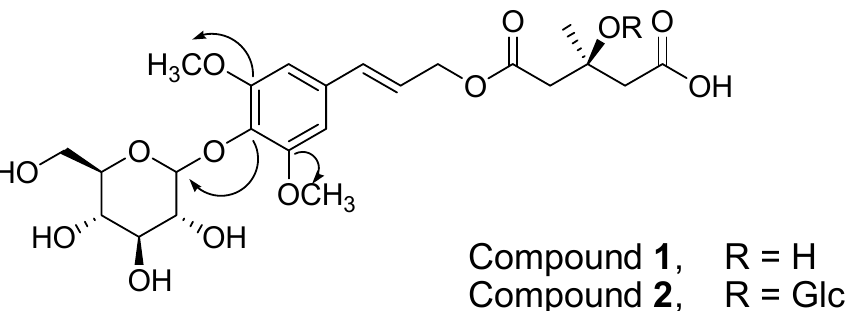
Figure 1. The chemical structures of compounds 1 and 2 , and the gHMBC correlation of compound 1 , which is shown by arrows.